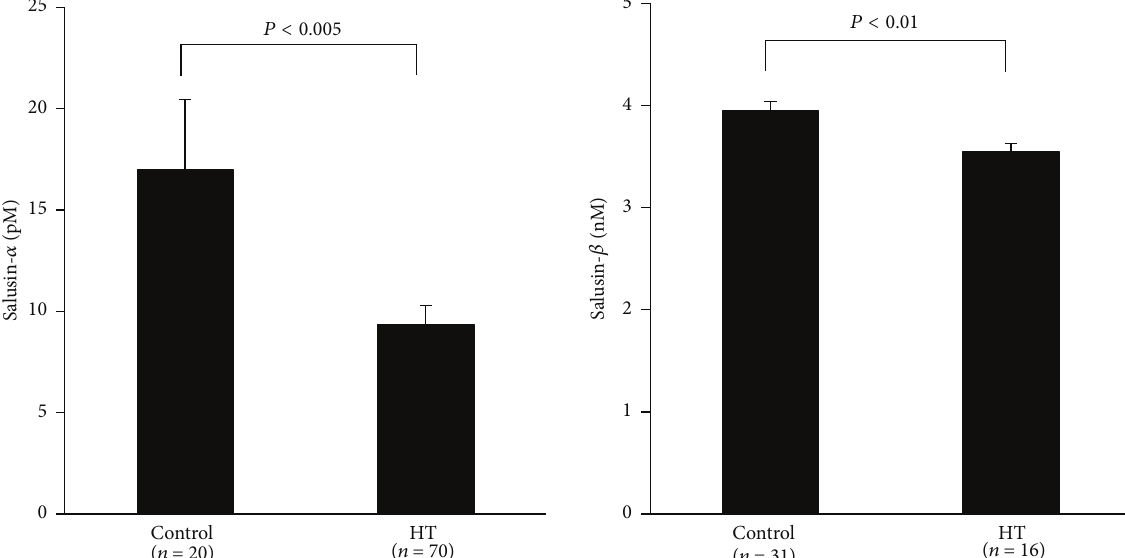
Figure 1: Comparison of circulating levels of salusin- 𝛼 and salusin- 𝛽 between normotensive subjects and hypertensive (HT) patients.